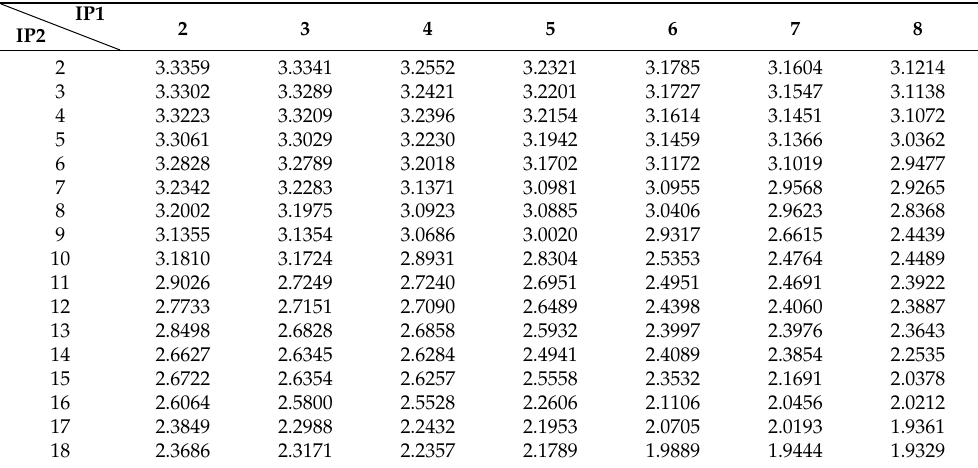
Table 4. The root-mean-square error ( RMSE , mm) between the hindcast amplitudes obtained by the EHA and the primary values with different numbers of IPs for the 8.85-year cycle at Boston.